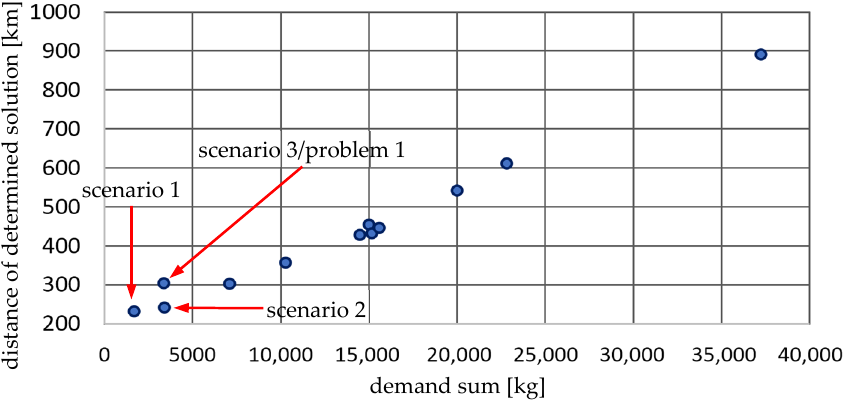
Figure 11. The distance of the route depends on the total demand of customers.